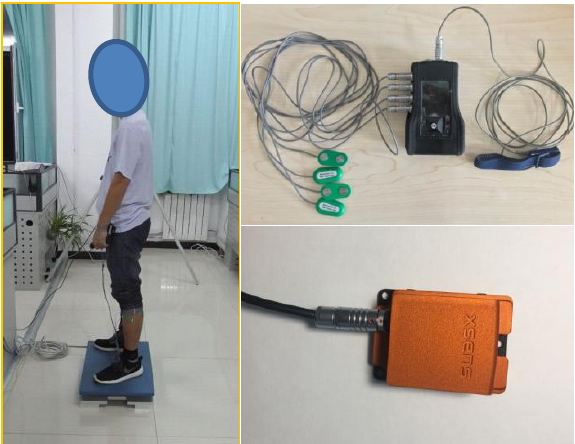
Figure 4. Upright standing push-recovery. Left picture shows a subject standing on the force plate. Pushing force is exerted on his back. Right upper picture shows the sEMG device. Right lower picture shows the IMU sensor.